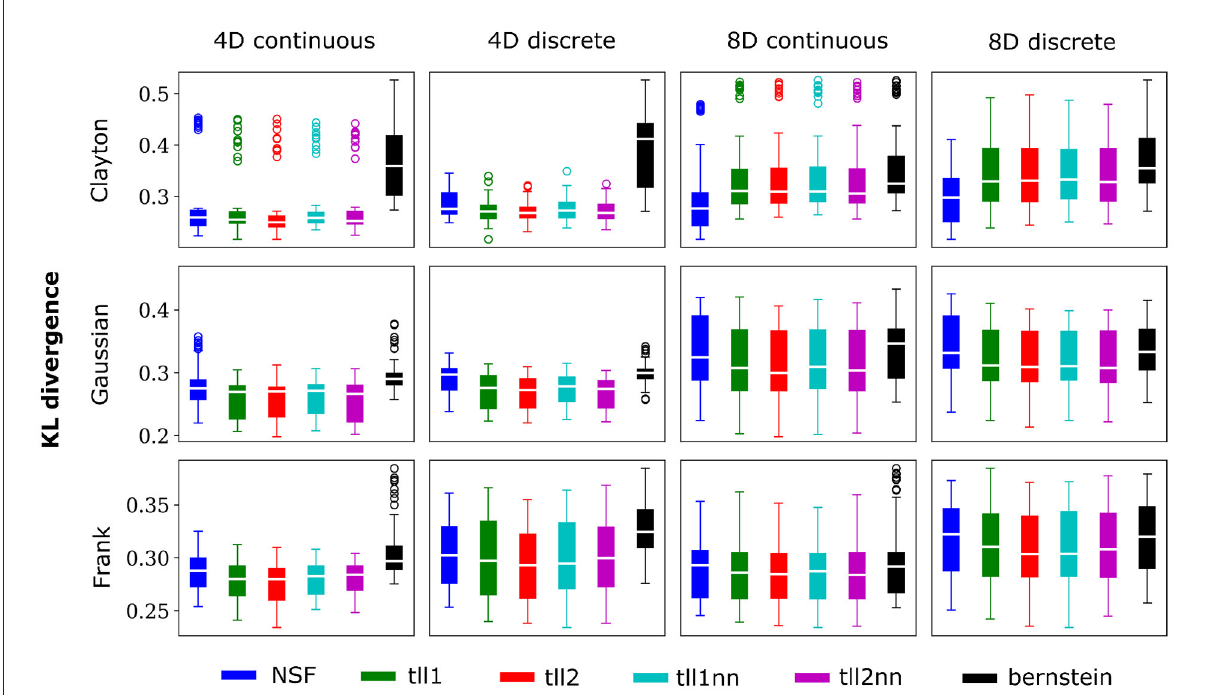
FIGURE3 Same conventions as Figure 2 but for simulations with strong dependencies described by Clayton ( θ = 5), Gaussian (0.8 in the off-diagonal), and Frank copulas ( θ = 7).